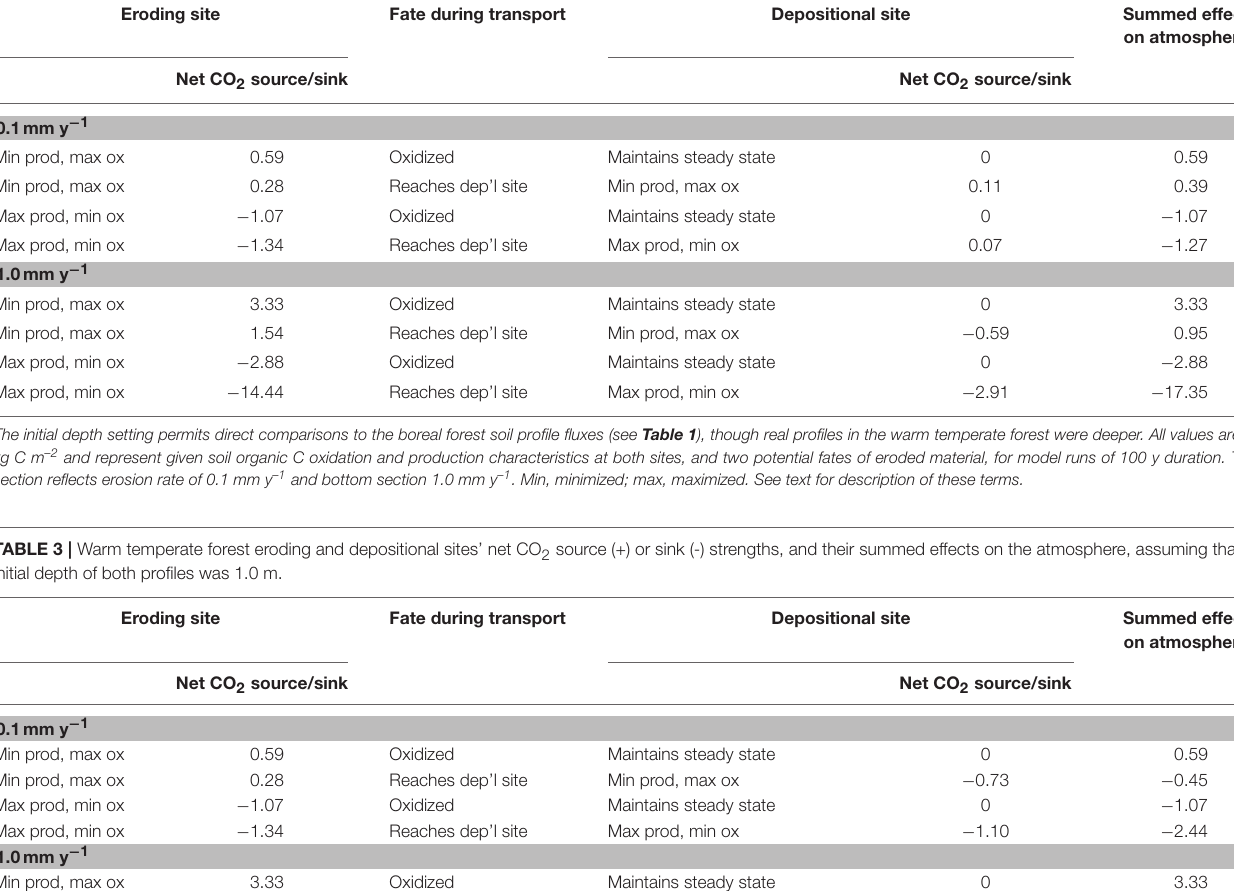
TABLE 2 | Warm temperate forest eroding and depositional sites’ net CO 2 source (+) or sink (-) strengths, and their summed effects on the atmosphere, assuming that initial depth of both profiles was 0.18 m. Eroding site